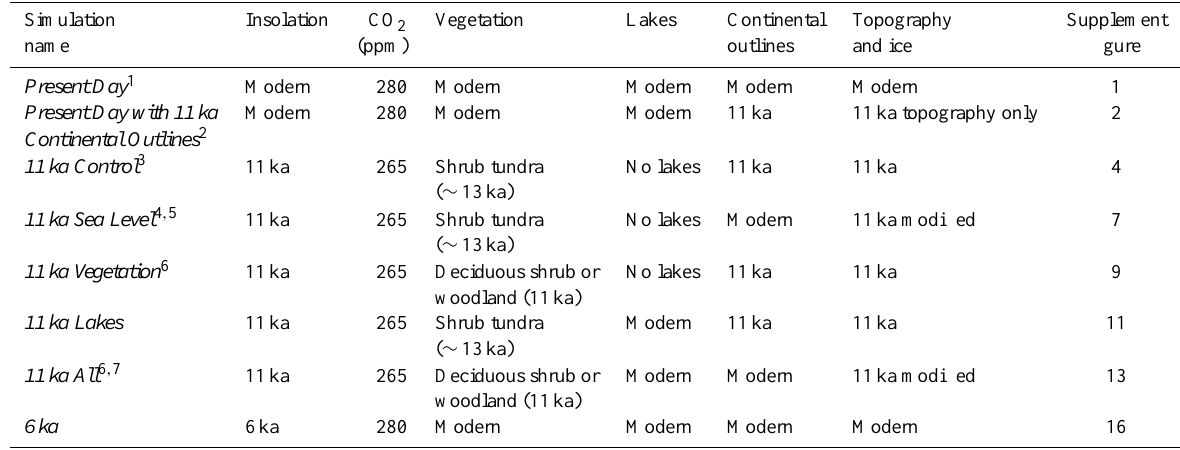
Table 1. Simulation boundary conditions and land cover.